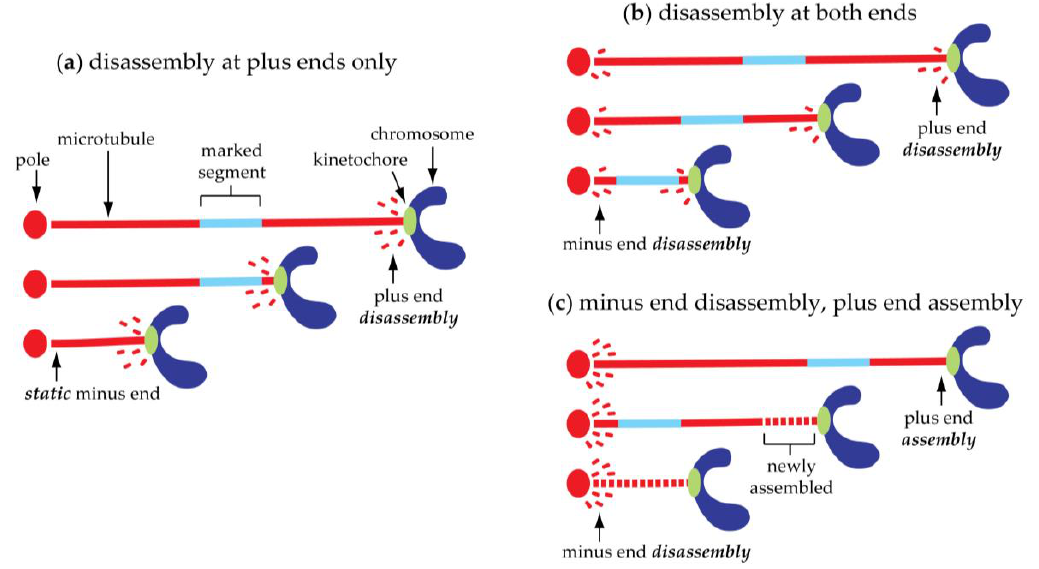
Figure 4. Chromosome-to-pole motion during anaphase A is coupled to microtubule disassembly. ( a ) Simple mechanism with disassembly occurring only at microtubule plus ends, as seen in yeasts, where minus end attachments to the poles are static and no flux occurs [26–29]. ( b ) Dual mechanism, as in cultured mitotic human cells, where chromosome-to-pole motion is a superposition of a kinetochore’s movement relative to the microtubules, which is coupled to plus end disassembly, and the microtubules’ flux relative to the poles, which is coupled to minus end disassembly [30]. ( c ) Mechanism observed for autosomal half-bivalents in meiotic crane-fly spermatocytes, with disassembly at minus ends and assembly at plus ends [10,31]. Switching between mechanism (b) and mechanism (c) has been directly observed in Xenopus egg extract spindles [32].